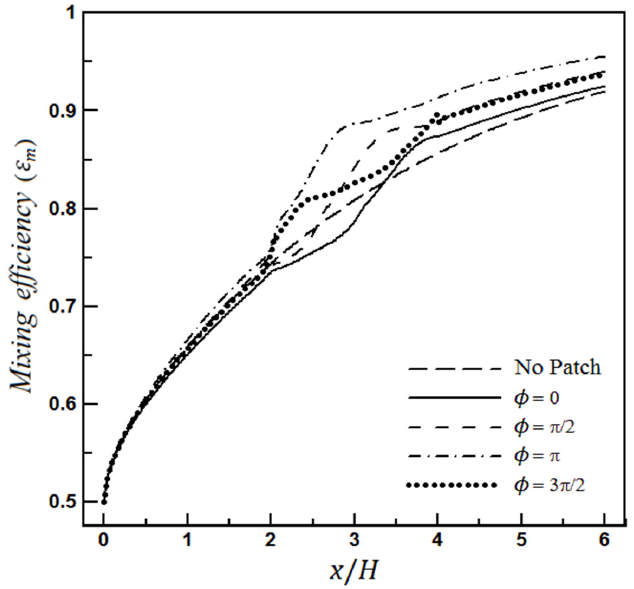
Figure 5. Mixing efficiency for flow fields of Relations (20) and (21).